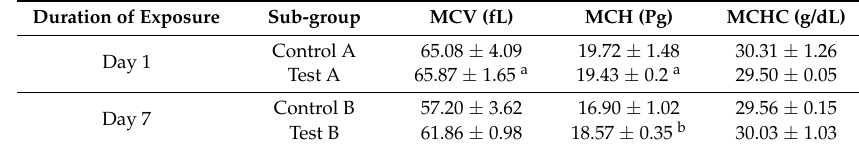
Table 2. Mean red blood cell indices as compared to